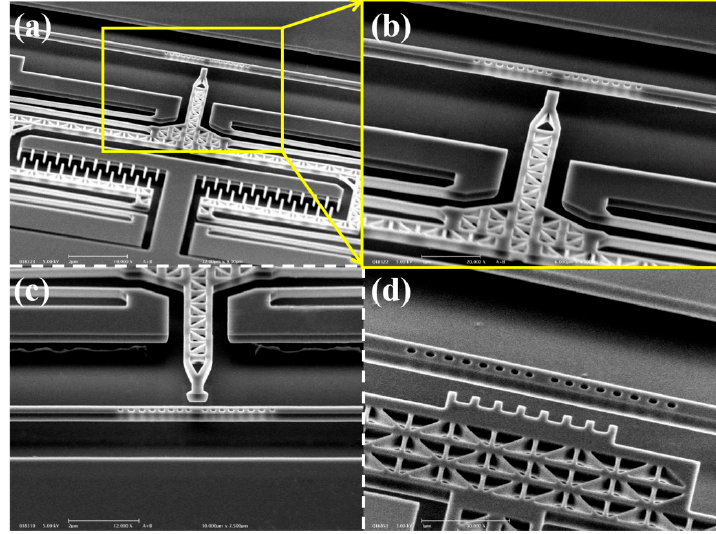
Figure 9. ( a ) SEM image of 1D PhC cavity resonance tuning mechanism using near-field perturbation approach with nano probe. Close-up views of ( b ) probe with a rectangular tip, ( c ) probe with a meniscus-like tip, and ( d ) probe with multiple tips.